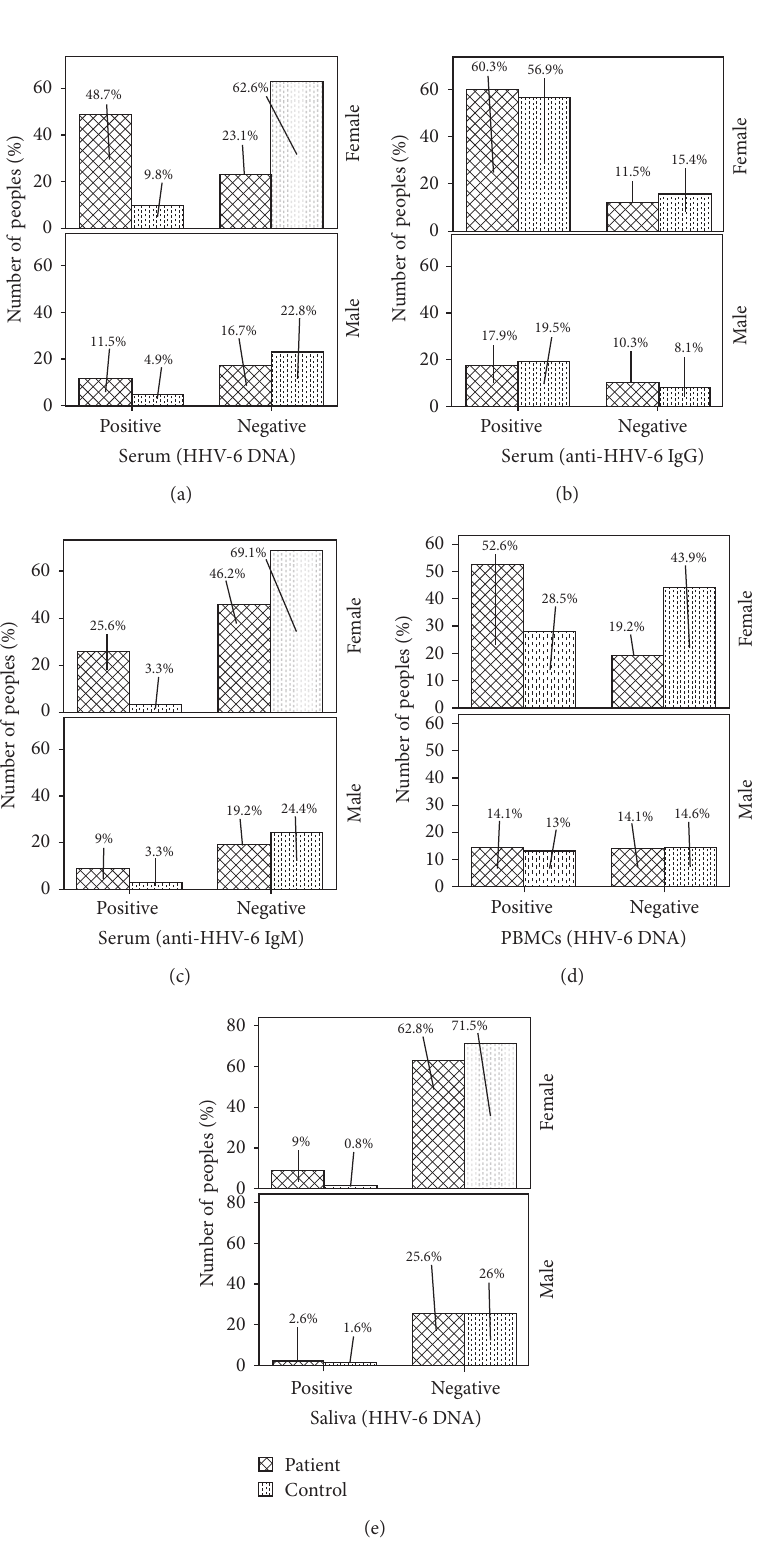
F 1: Prevalence of HHV-6-DNA and its antibodies among male and female in healthy controls and MS